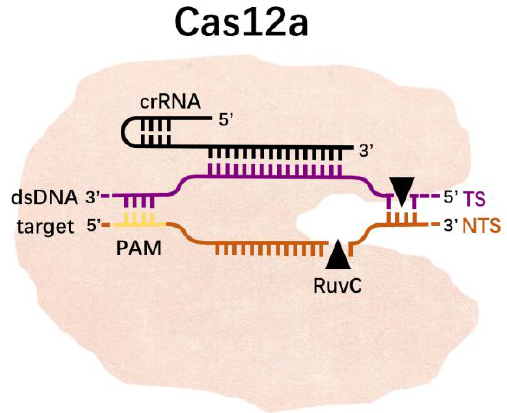
Figure 4. Cas12a-crRNA complex binds a dsDNA substrate and generates a 5′ -overhang staggered cut by using a single RuvC nuclease.